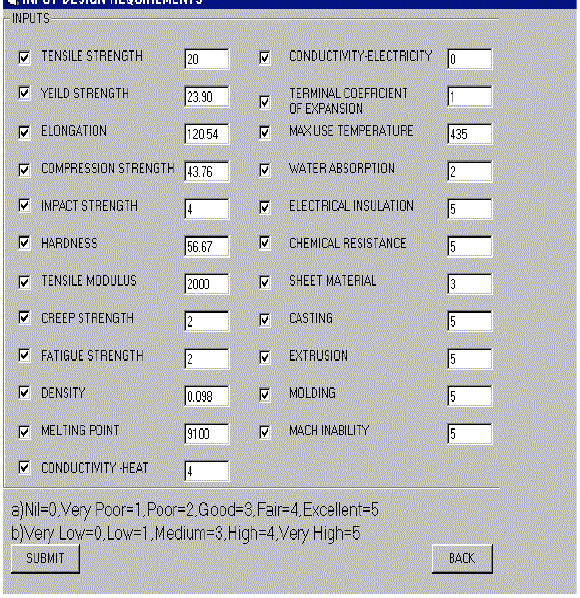
Fig. 6: Materials selected using Euclidian Distance Measure.